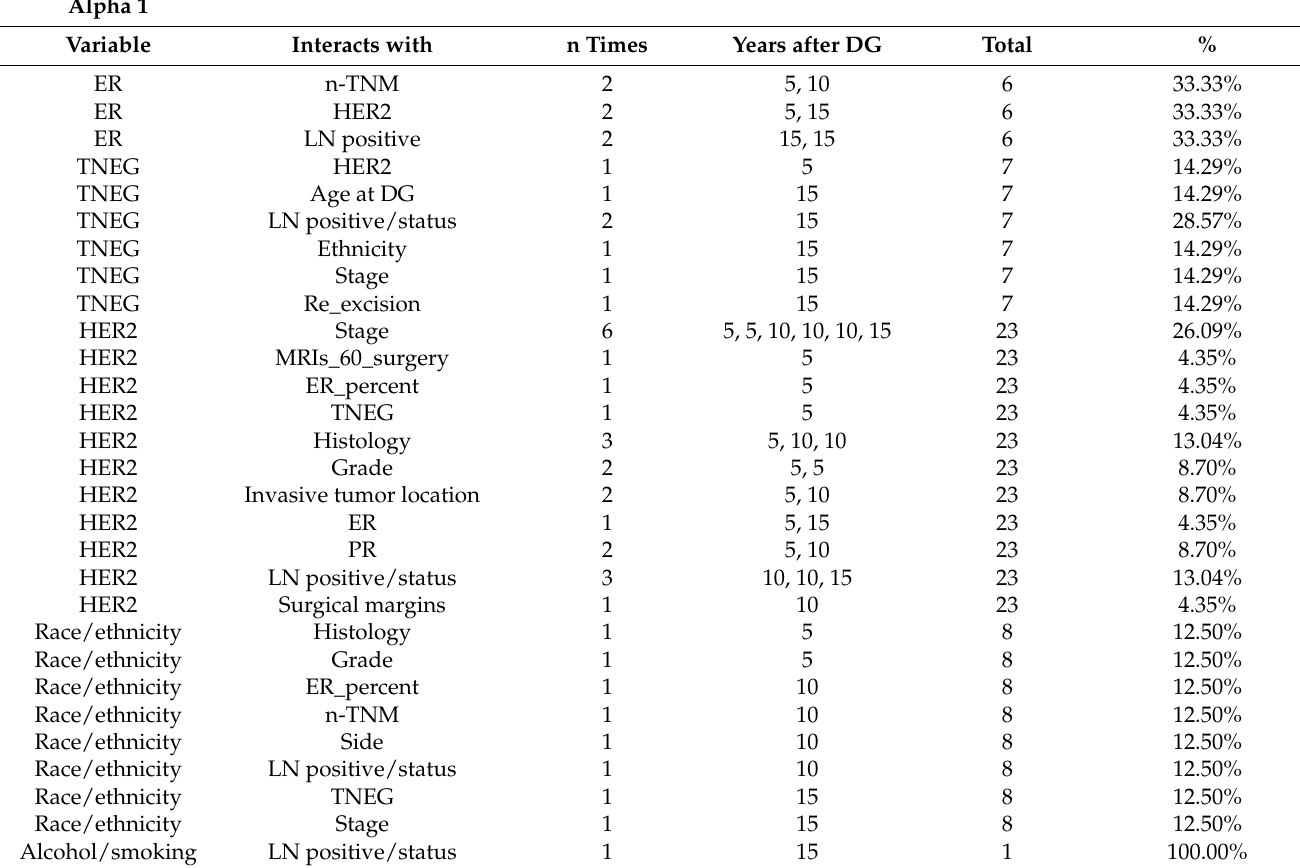
Table 2. Variables interacting with an alpha of 1. ER, TNEG, HER2, race/ethnicity and alco- hol/smoking are represented with their interacting variables, the number of times they interacted, the years after diagnosis when these interactions were risk factors for metastases, the total number of times the variables interacted and frequency of interaction.